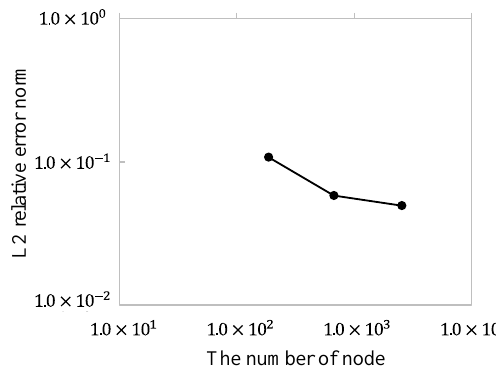
Figure 20. Convergence rates for the PDM simulation with a fixed number of TPs.